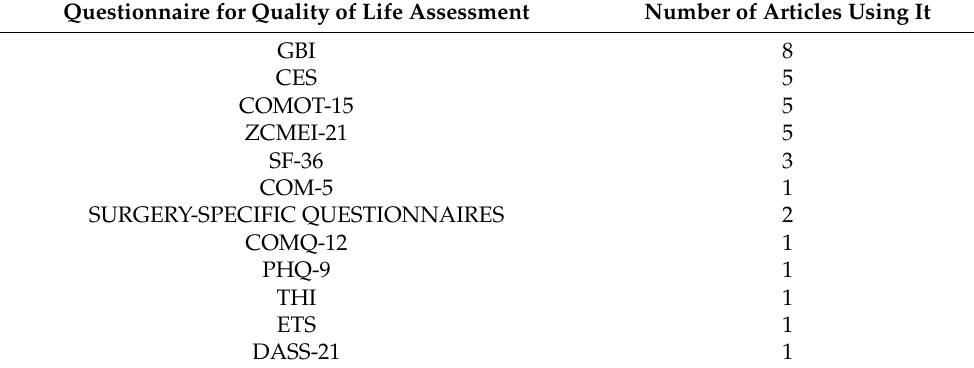
Table 3. Subjective questionnaires used to evaluate quality of life in patients undergoing surgery for chronic otitis